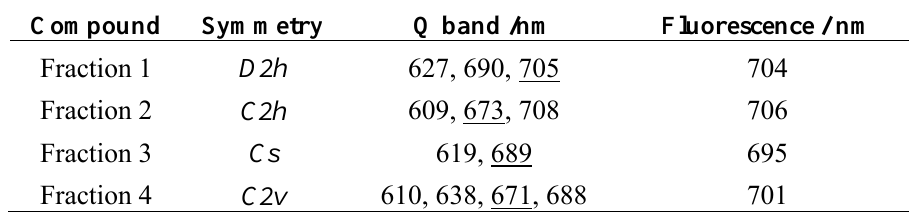
Table 10. Absorption and fluorescence maxima for each fraction of 5c in solution.